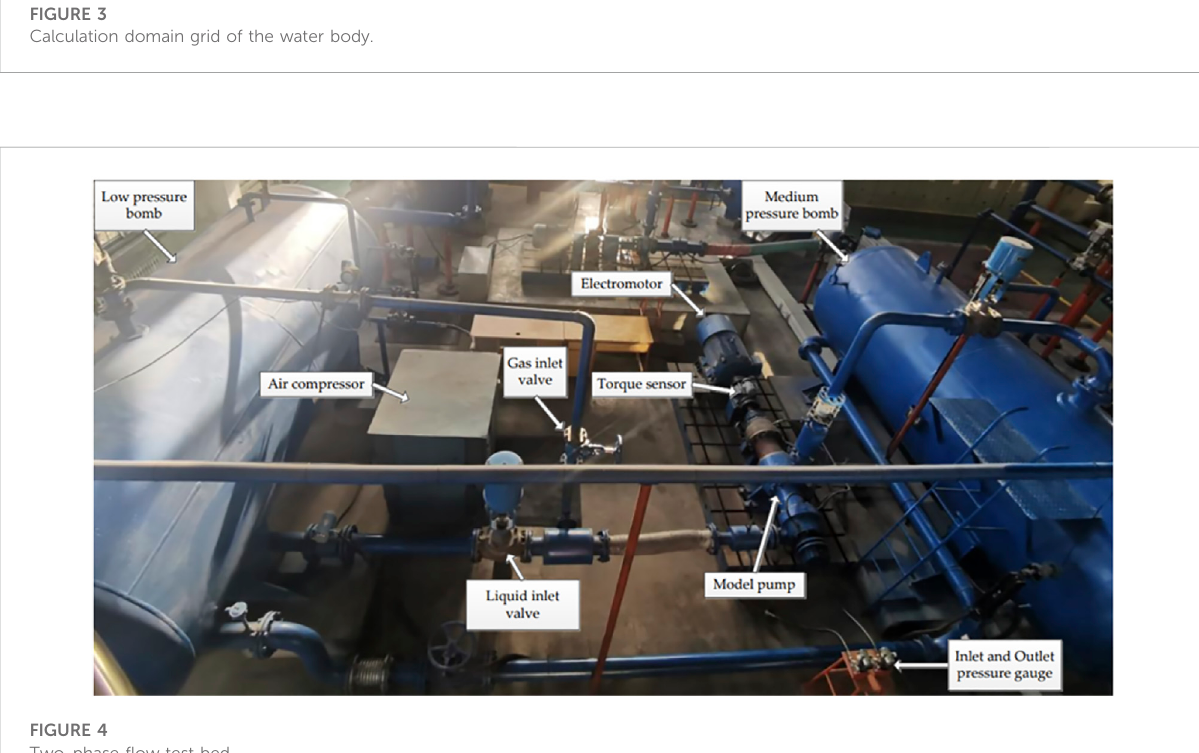
FIGURE 4 Two-phase fl ow test